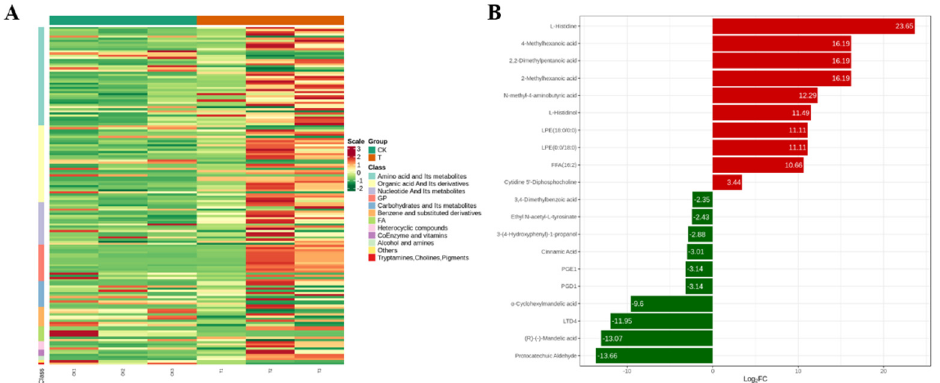
Figure 9. ( A ) Heatmap of differentially accumulated metabolites. ( B ) Top 10 DAMs in control and treatment.